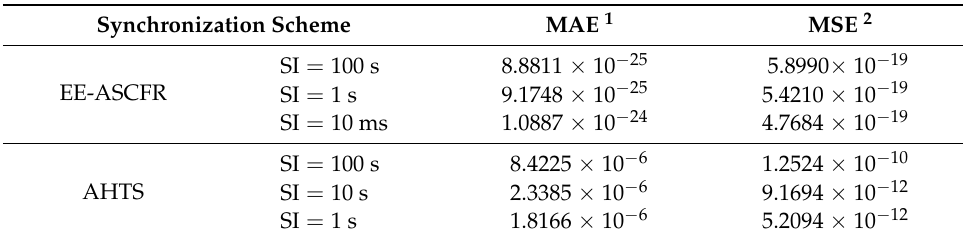
Table 1. MAE and MSE of measurement time estimation of EE-ASCFR and AHTS with different synchronization intervals (SIs) provided in [1] and